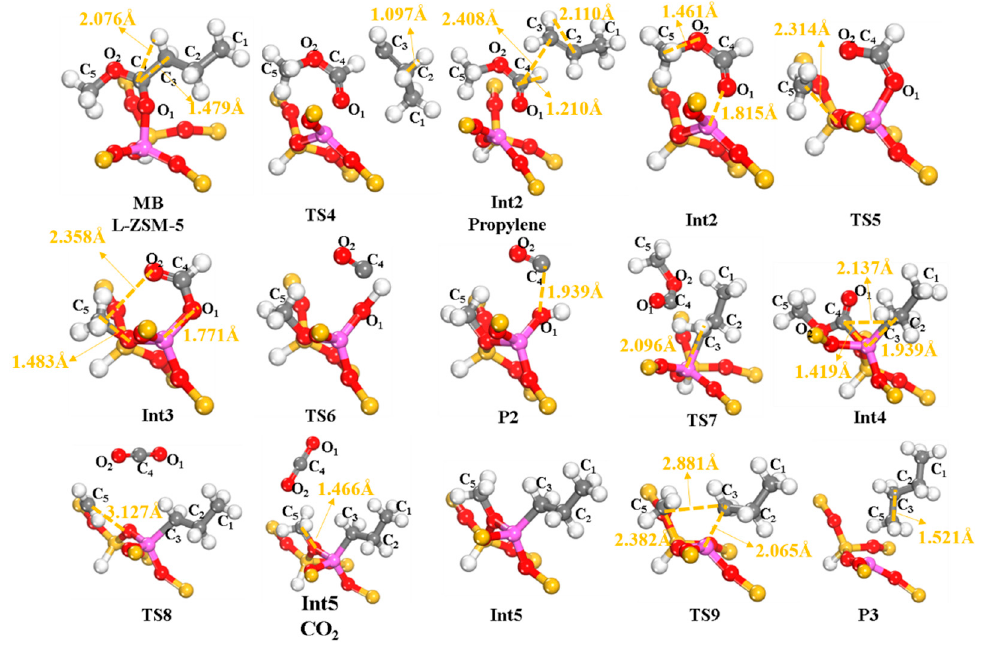
Figure 4. The structures of initial, transition, and final states for the α -C–C bond cleavage of MB on 32 T cluster of ZSM-5.